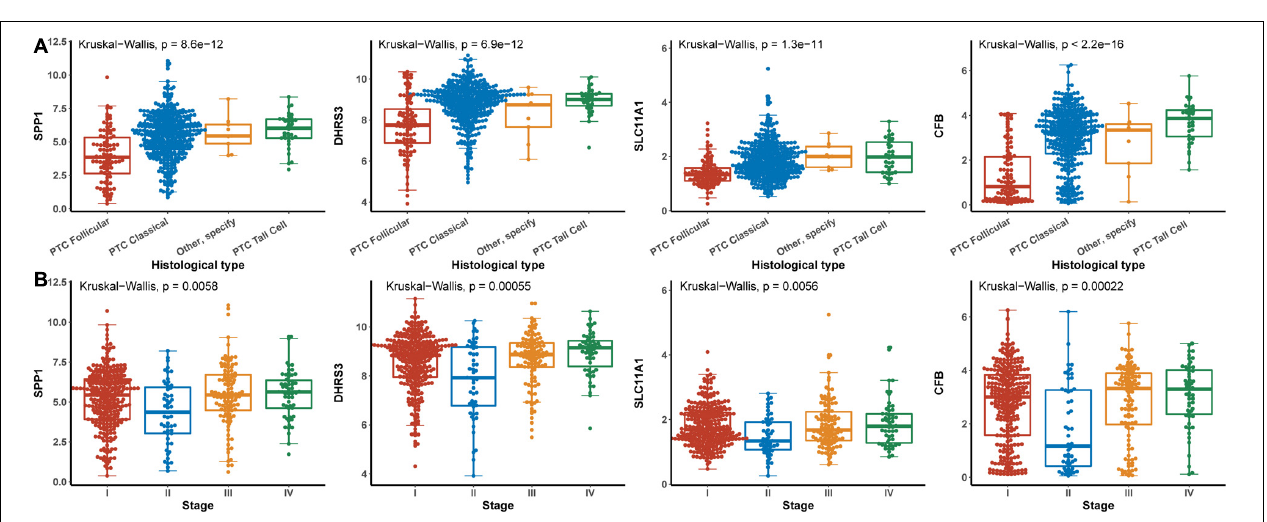
FIGURE 4 | Relationship between hub genes and histological type and pathological stage. (A) Histological type. (B) Pathological